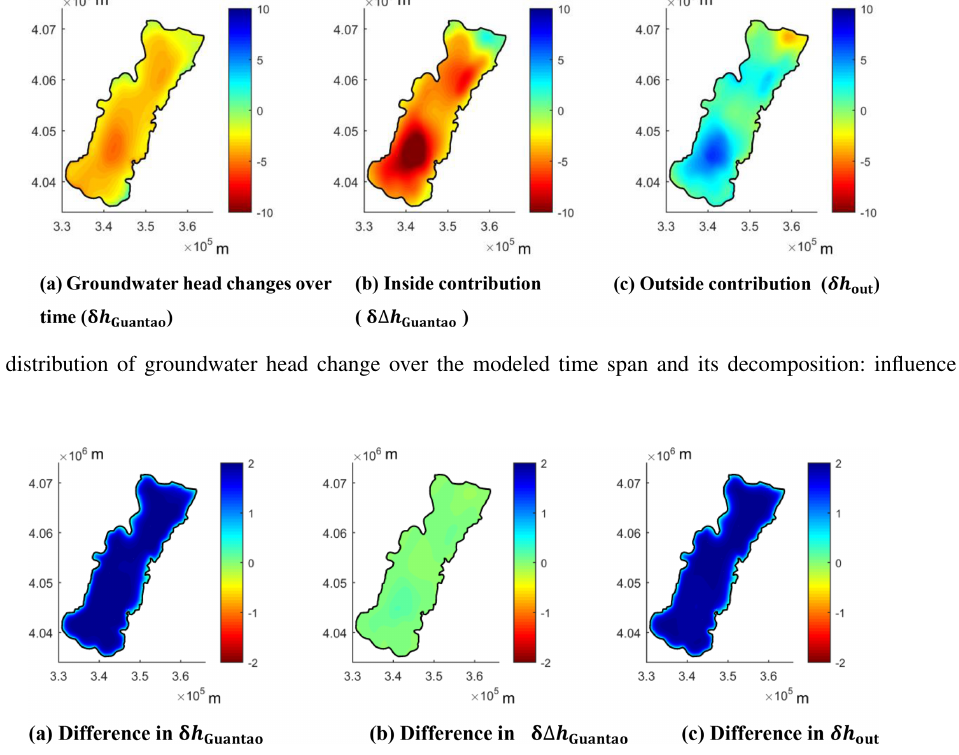
Figure 15. Differences between the model runs with and without increased specified heads on the